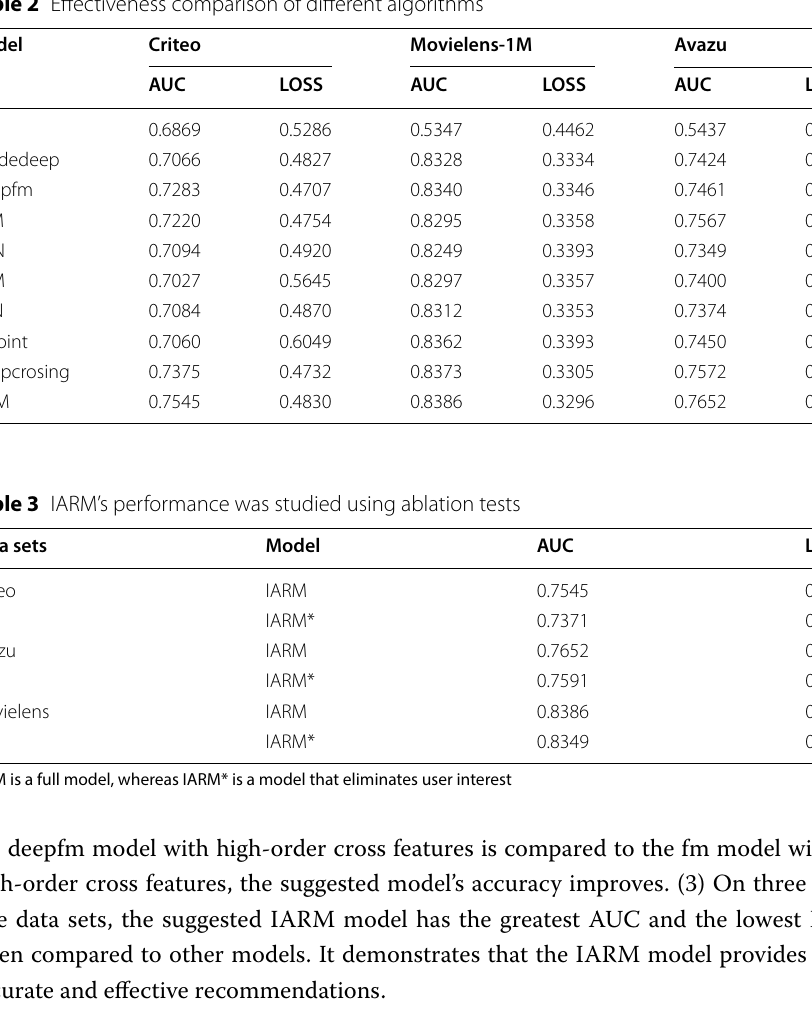
Table 2 Effectiveness comparison of different algorithms Model